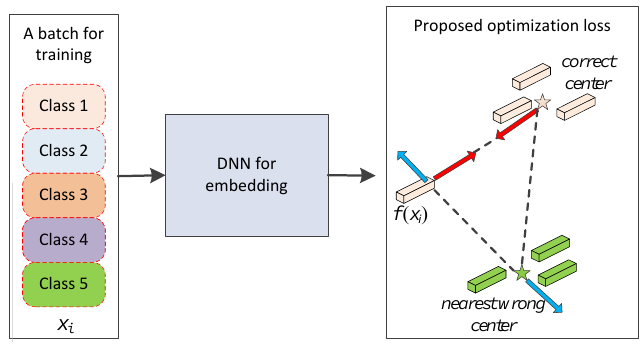
Figure 2. The architecture of the proposed feature